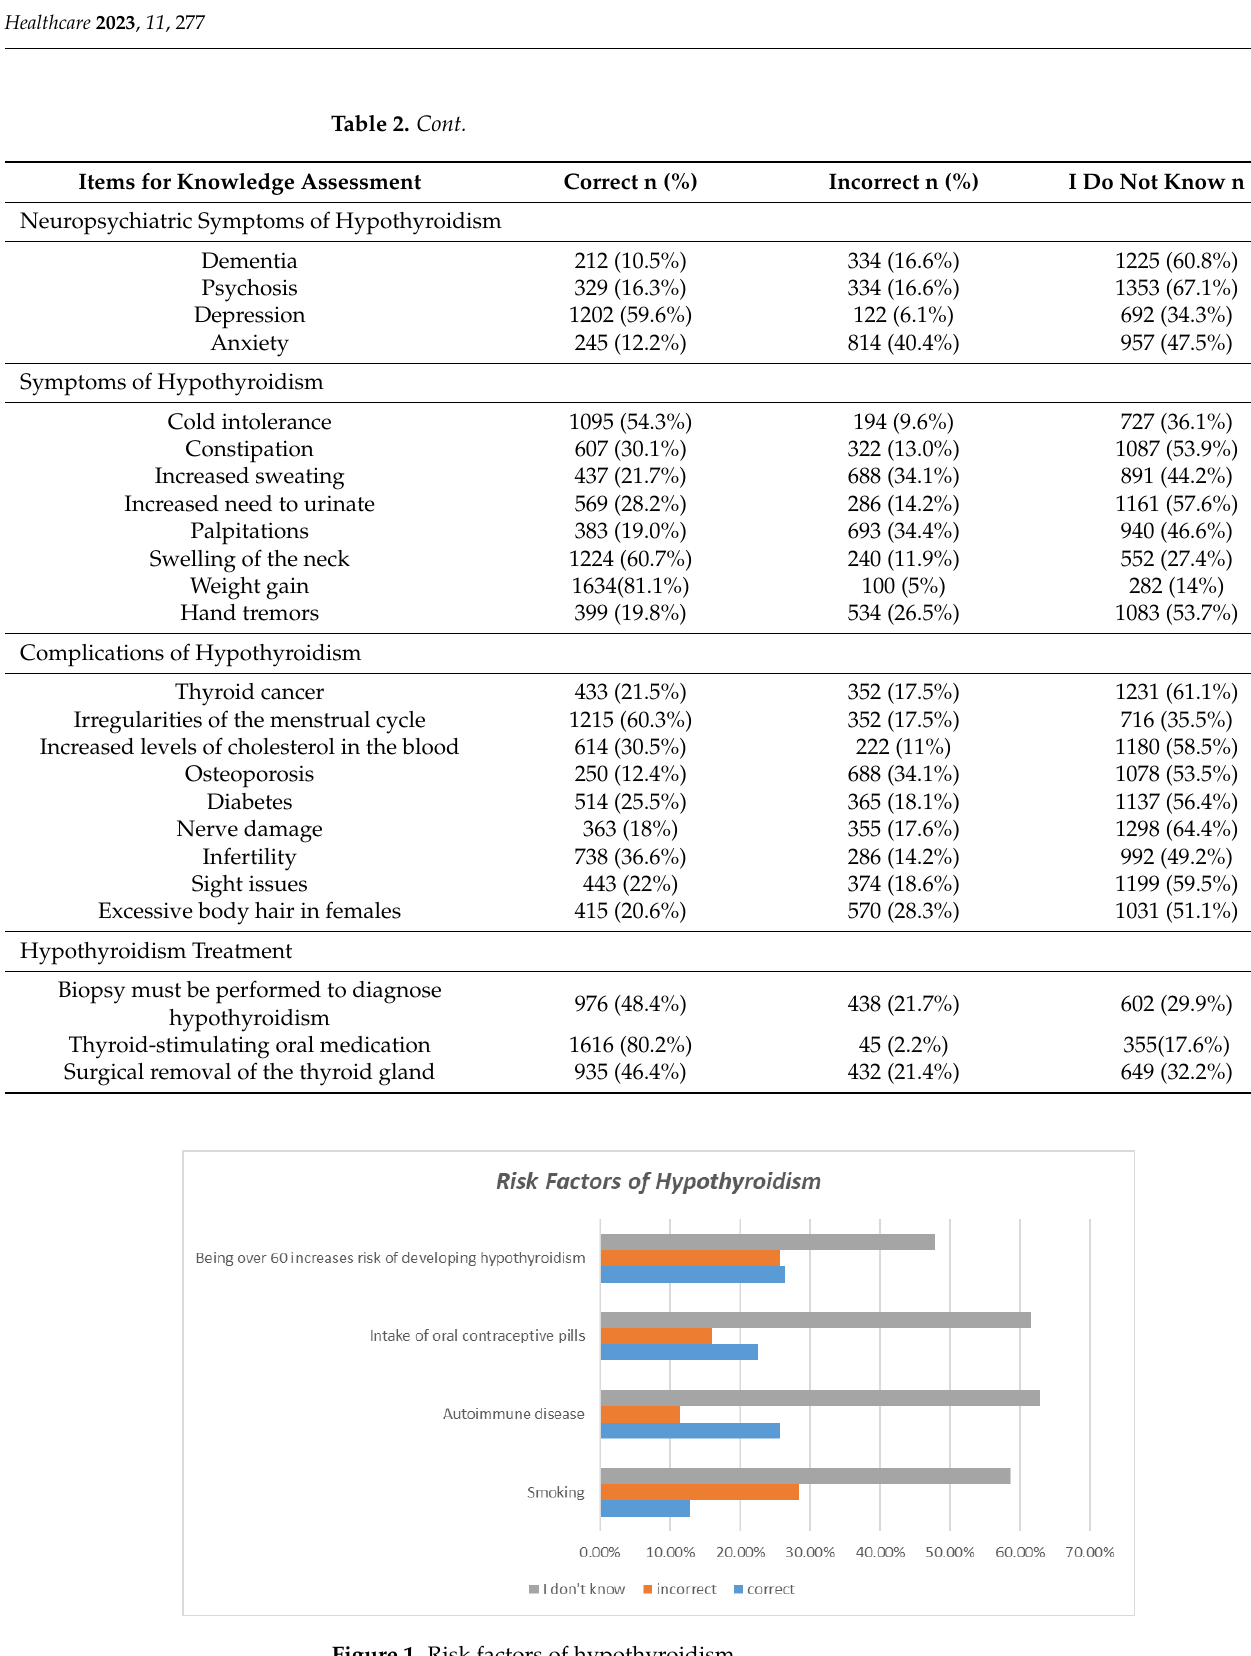
Figure 1. Risk factors of hypothyroidism.